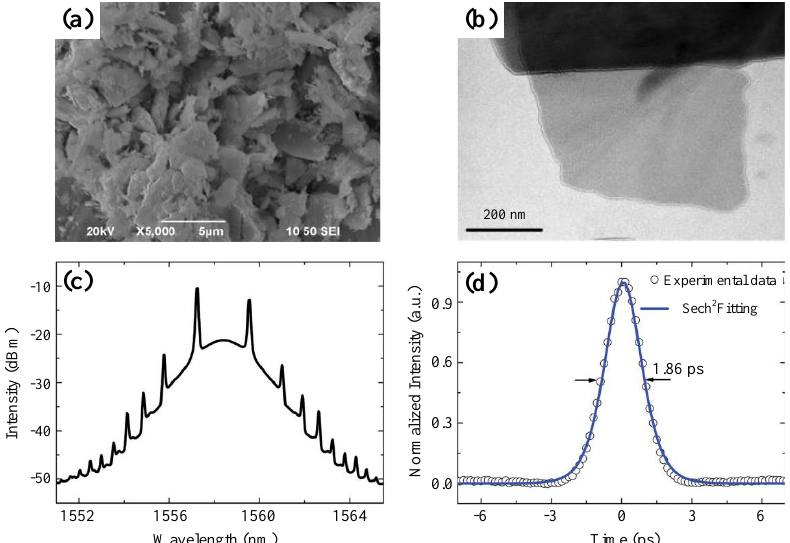
Figure 9. The experimental results of mode-locked EDFL enabled by Bi 2 Te 3 SA. ( a ) SEM and ( b ) TEM images of Bi 2 Te 3 nanosheets prepared by the hydrothermal intercalation/exfoliation method. ( c ) Soliton spectrum. ( d ) Autocorrelation trace. ( a – d ) adapted with permission from [217]. Copyright 2012 American Institute of